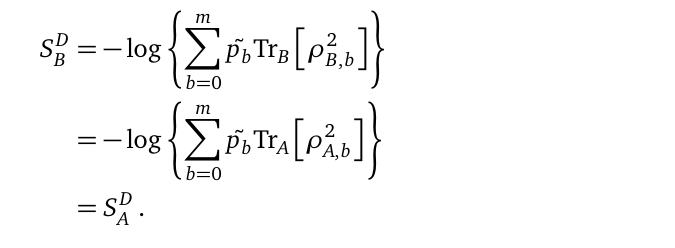
Figure 7: The entanglement entropy computed on the single realization of a quantum trajectory. Here, U = J and the number of sites N = 3, and subsystem size L = 3. The measurement rate is γ/ J = 1.5. N b A (cid:148) (cid:151) (cid:148) (cid:151) ρ 2 = Tr ρ 2 that Tr , thus we A B A , b B , b